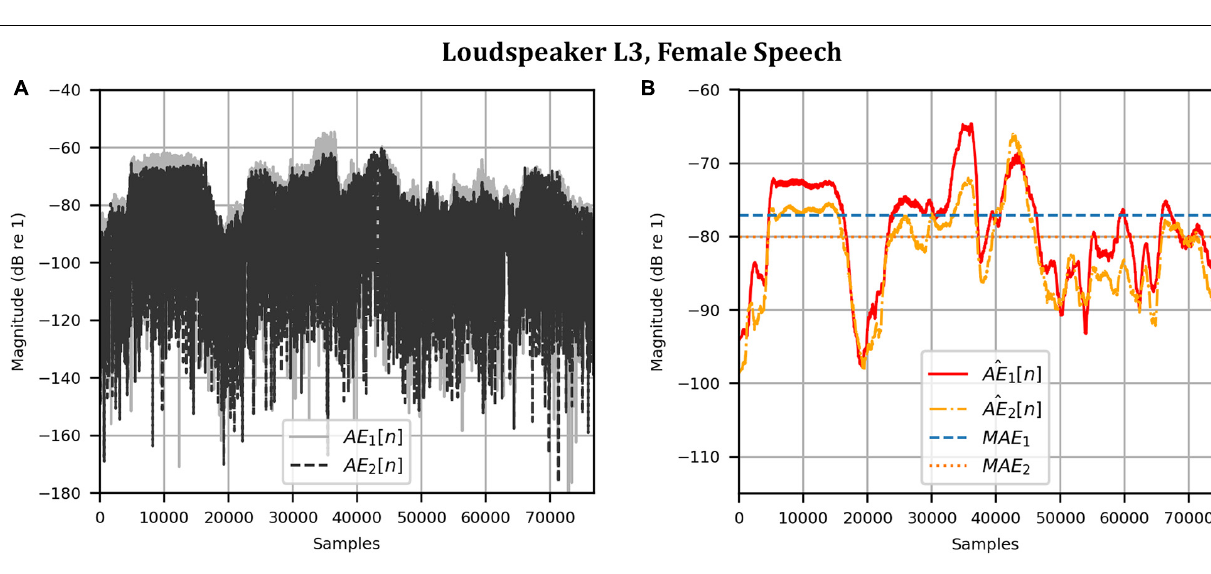
FIGURE 13 | Clinical booth: Error metrics quantifying the difference between the target and reproduced time domain waveforms in Figure 12 : (A) Unsmoothed absolute errors; (B) Smoothed absolute errors and mean absolute